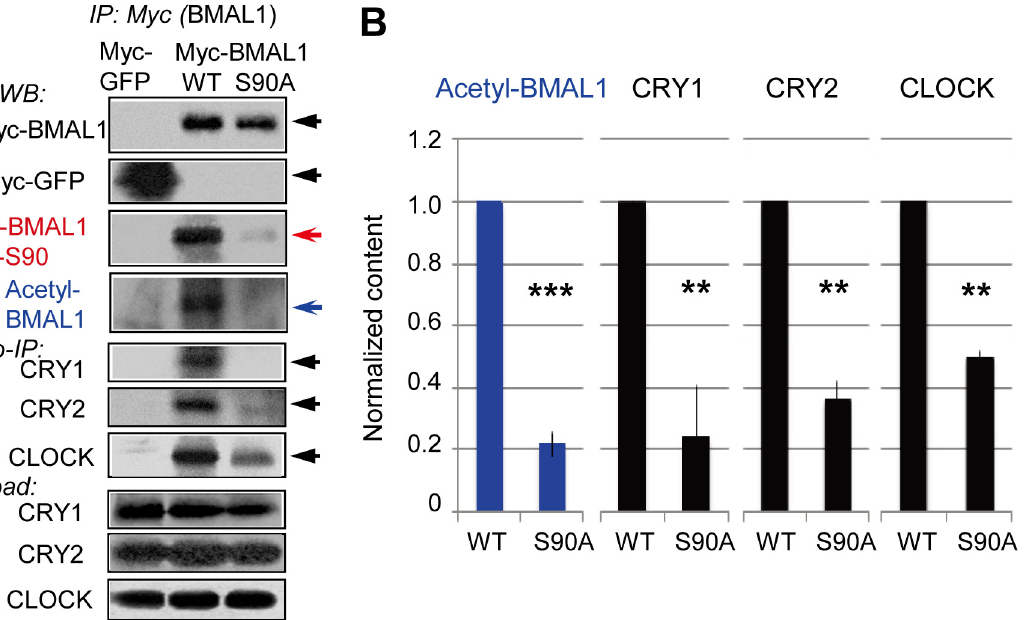
Fig 7. BMAL1-S90 phosphorylation is prerequisite for BMAL1-K537 acetylation and subsequent recruitment of CRY to BMAL1. (A) Bmal1 − / − MEFs stably expressing mBmal1 promoter-driven Myc-BMAL1-WT (wild type), Myc-BMAL1-S90A (CK2 − phosphorylation site-deficient mutant), and CMV- promoter-driven Myc-GFP (control) were Dex-synchronized. The supernatants from the cells harvested 22 h after treatment were subjected to Myc-BMAL1 IP. The Myc-BMAL1 IPs and total lysates (Load) were subjected to IB analysis for Acetyl-BMAL1 and BMAL1- co-immunoprecipitated (Co-IP) CRY1/2 and CLOCK. (B) Normalized Acetyl-BMAL1 and BMAL1-bound CRY1/2 and CLOCK levels are shown in the graph ( n = 3 experiments) and error bars indicate